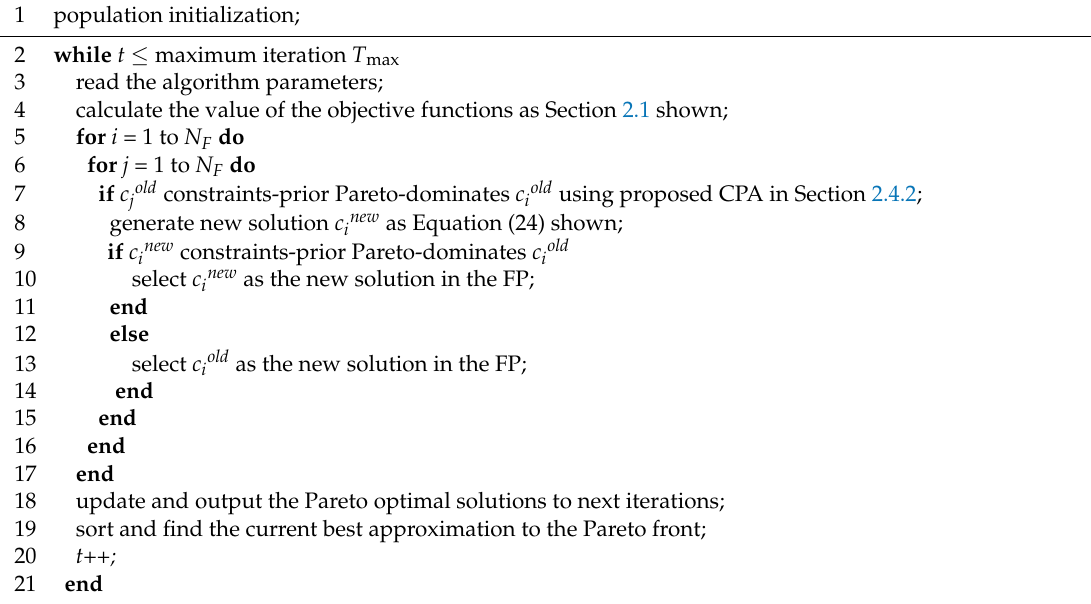
Table 2. Pseudo code of the multi-objective firefly algorithm–constraints-prior Pareto-domination approach (MOFA-CPA)